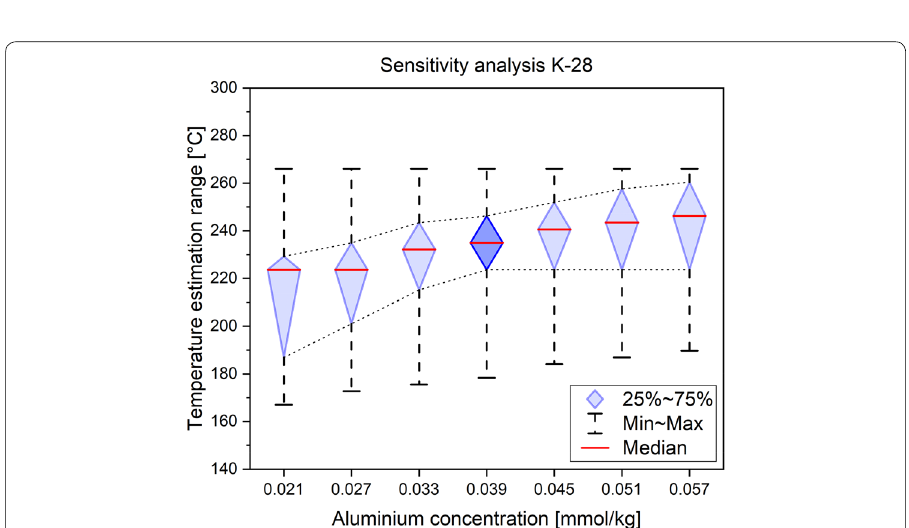
Fig. 4 Sensitivity analysis of aluminium concentration for sample K-28. The value was varied from 0.009 to 0.117 mmol/kg in increments of 0.006 mmol/kg. The figure shows an extract of the data, where